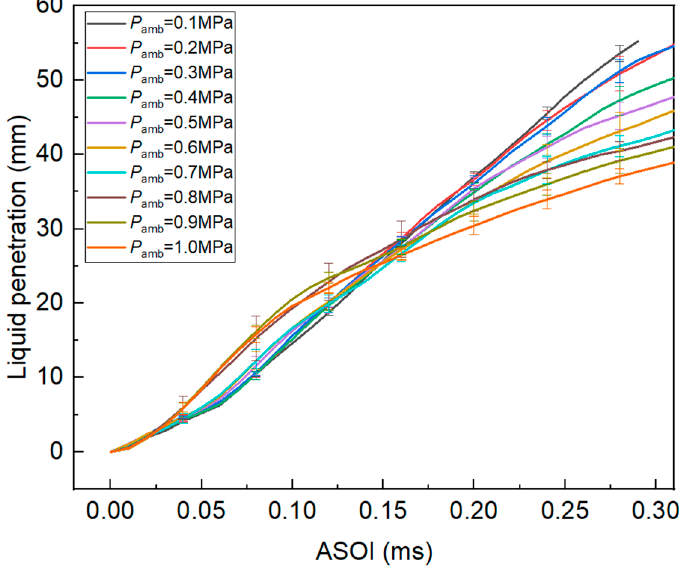
Figure 9. Liquid penetration in flash boiling conditions in detail; P inj = 100 MPa; fuel: liquid ammo- nia.